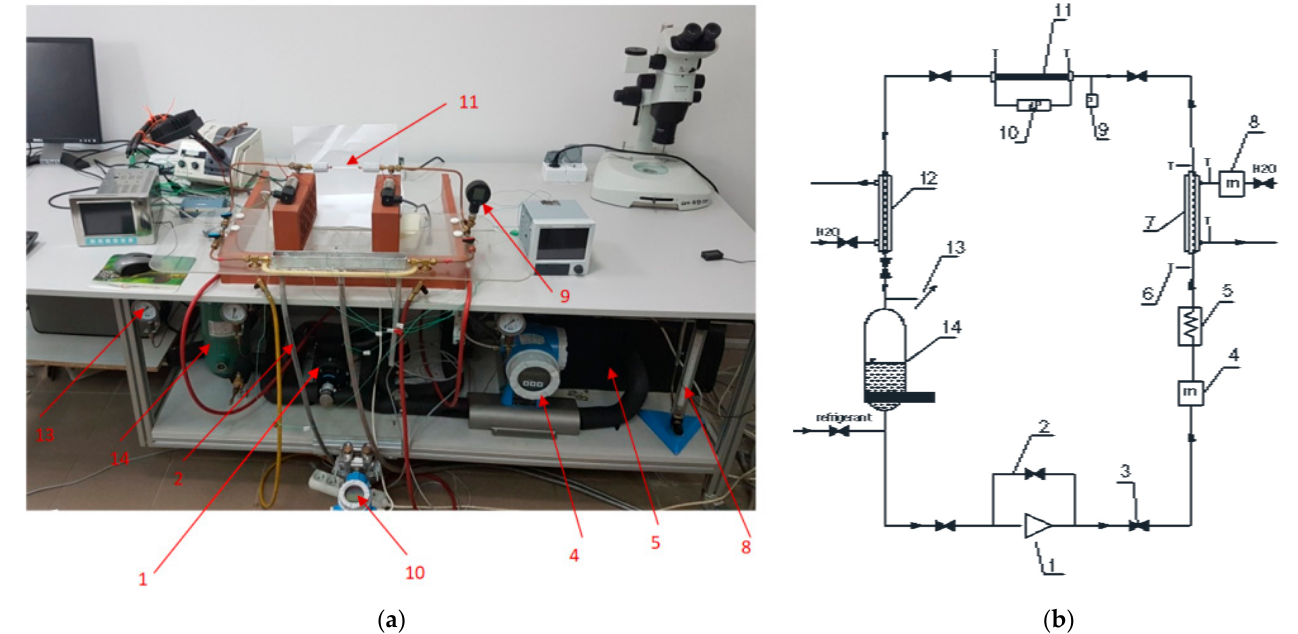
Figure 1. Test stand: ( a ) overview; ( b ) schematic diagram; 1—ceramic pump, 2—bypass for flow rate control, 3—valve, 4—electronic flow meter for refrigerant, 5—evaporator, 6—manometer, 7—preliminary heat exchanger of “tube ‐ in ‐ pipe”